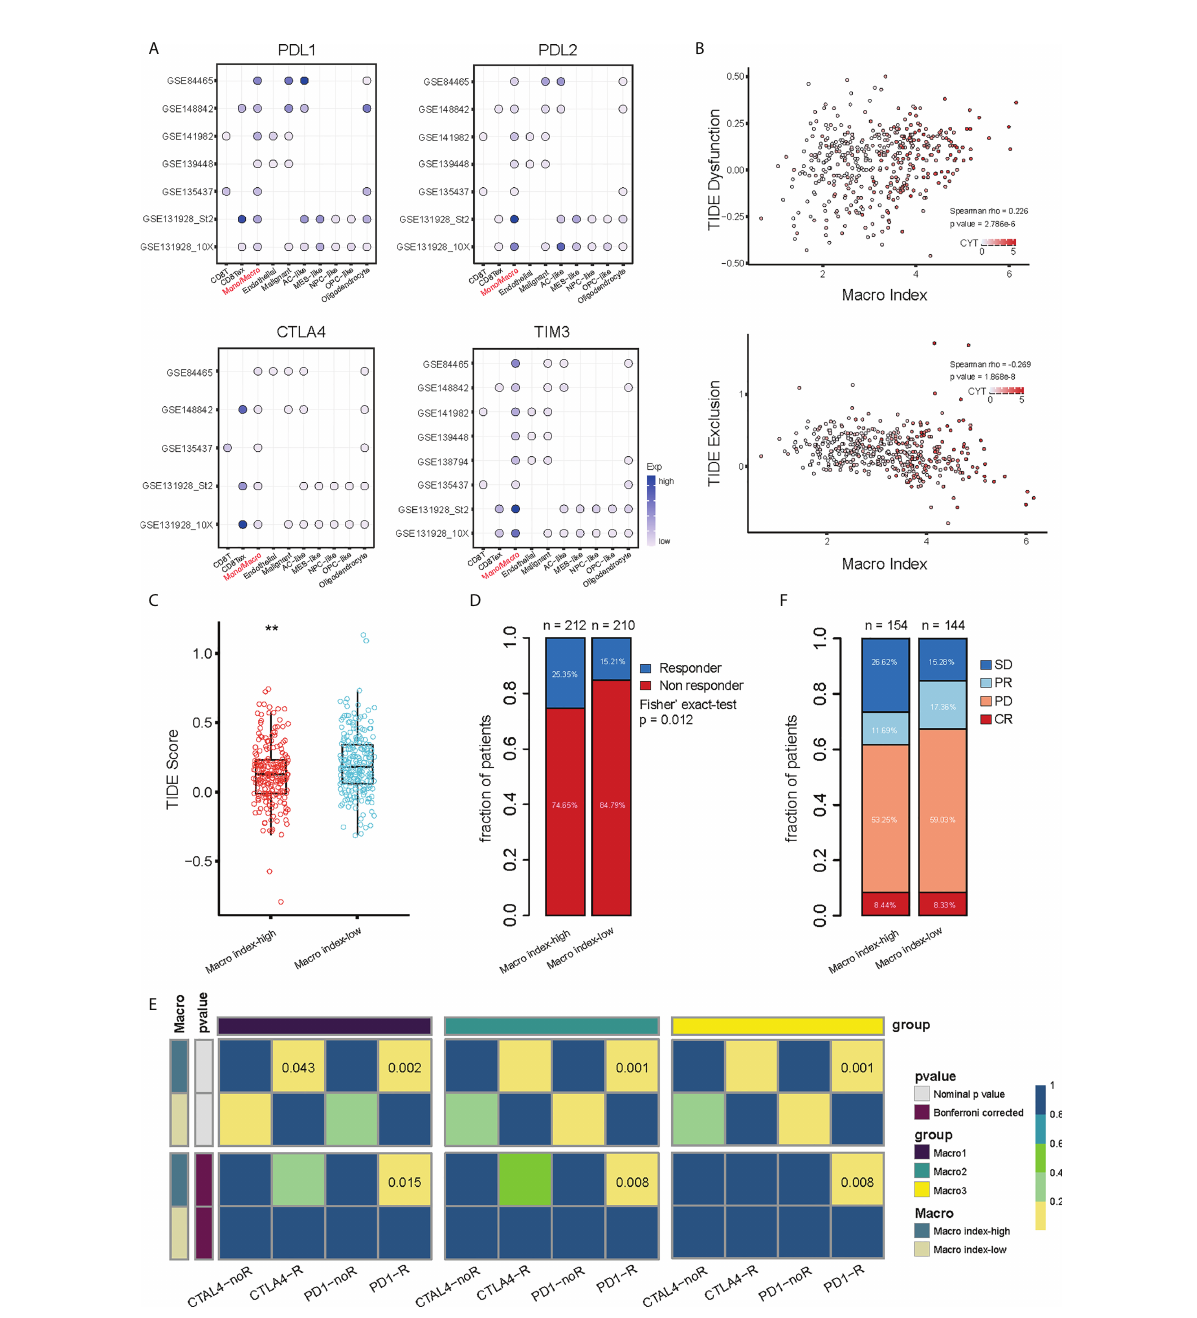
FIGURE 7 Association between the Macro index and ICI responsiveness. (A) Expression of immune checkpoints by different types of cells in the glioma TME at the single cell scope. (B) Association between the Macro index, TIDE T cell Dysfunction score, TIDE T cell Exclusion score, and CYT. Spearman rho measures the correlation between Macro index with Dysfunction and Exclusion scores. (C) TIDE score between Macro index- high and -low groups of TCGA glioma. (D) Distribution of predicted ICI responders and non-responders between the Macro index-high and -low groups. (E) Sample responsiveness to anti-PD1 or anti-CTLA4 was evaluated using the unsupervised Submap algorithm. (F) Macro index- based group in predicting the ICI bene fi t of the uroepithelial carcinoma sample. SD, stable disease; PR, partial response; PD, progression disease; CR, complete response. **p <